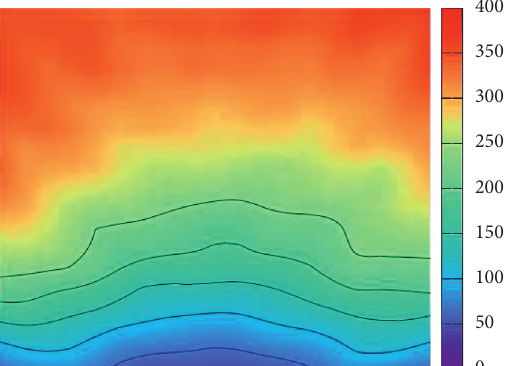
Figure 4: The contact pressure tr [ σ ]( Pa ) near the orifice (a zone at the yellow box shown in Figure 2) for a typical case with h � 600mm. ij